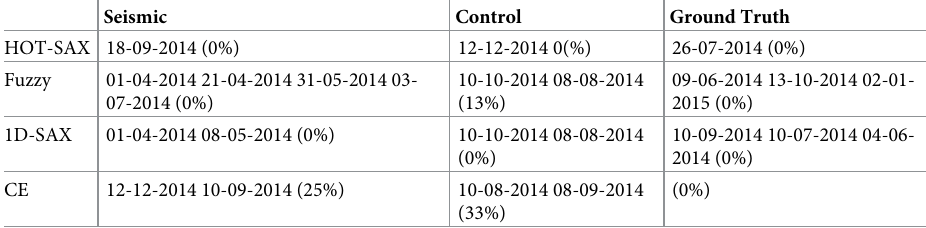
Table 5. Swarm B Grid 5, Ludian experimental